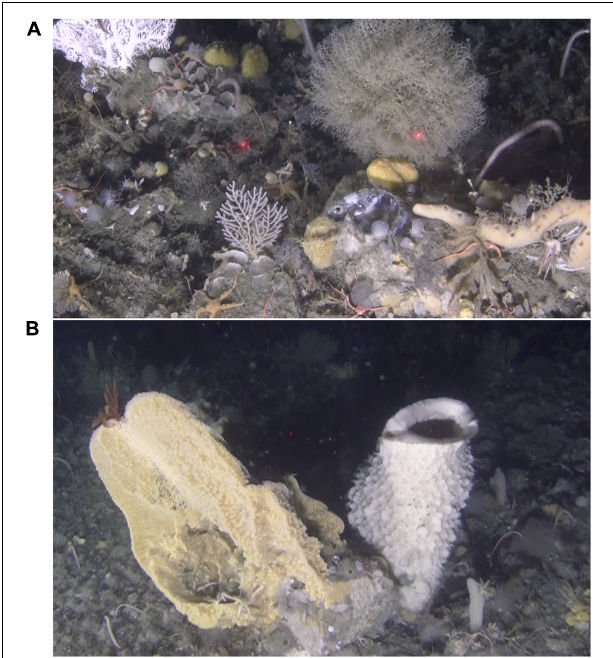
FIGURE 7 | VME off Trinity Island, western Antarctic Peninsula, ∼ 200 m (Dive 5). (A) An Antarctic rockcod enjoys ample protection among the complex assemblage at this site. A stylasterid (CITES protected) is seen in the upper left corner. (B) Although the lasers point into the background of this image, they crossed the hexactinellid on the right which measured > 25 cm in